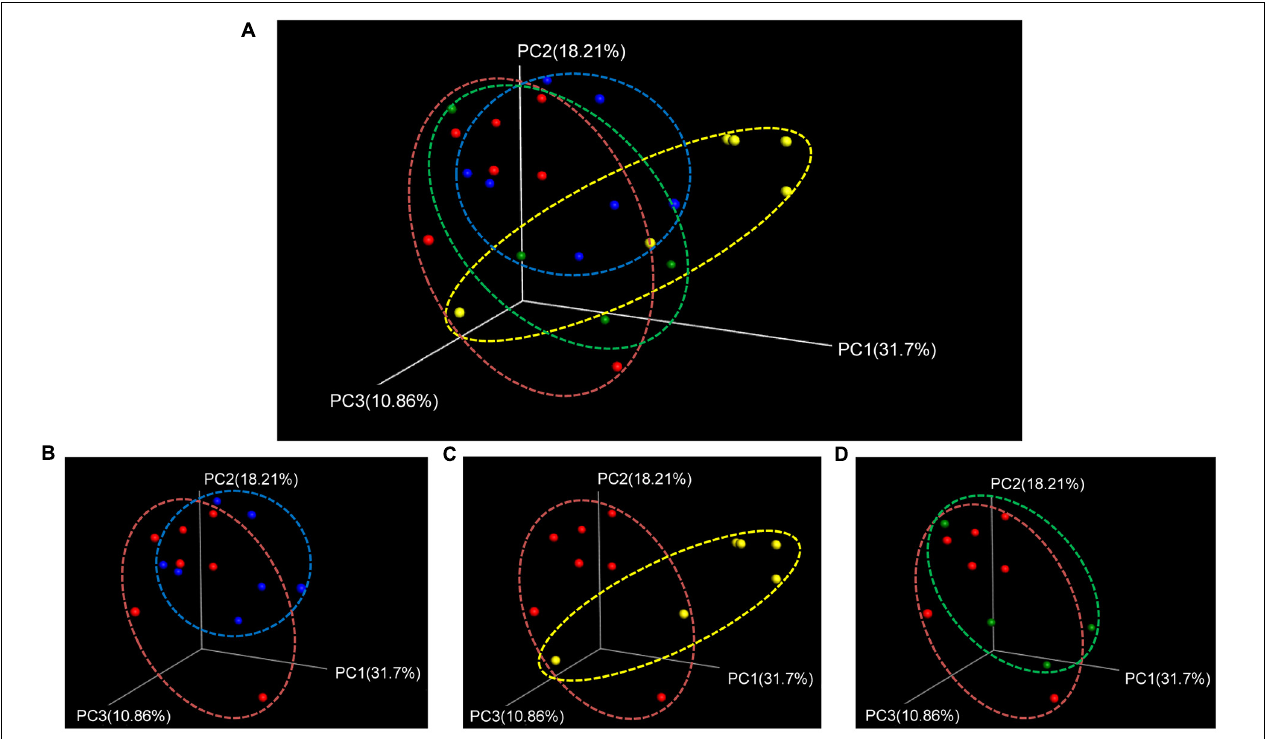
FIGURE 4 | Beta-diversity (weighted UniFrac PCoA plots) showed trending differences between pre- and poststroke in middle cerebral artery occlusion (MCAO) pig model. (A) Beta-diversity changes during the acute stage of stroke were shown by PCoA plots. Different bacterial communities were compared between (B) prestroke ( n = 7) vs. 1 day poststroke ( n = 7), (C) prestroke vs. 3 days poststroke ( n = 6), and (D) prestroke vs. 5 days poststroke ( n = 4). Trending differences were observed between prestroke and 3 days poststroke (non-parametric P- values generated by the Bonferroni’s multiple comparisons test were used for